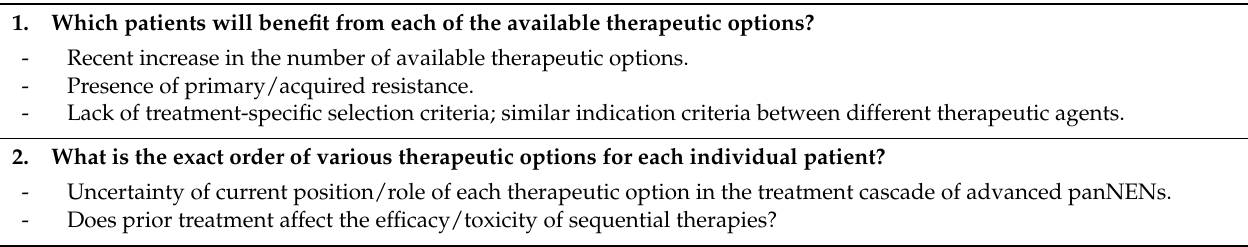
Table 1. Reasons for the emerging need for prognostic markers predictive for response/survival and/or development of resistance with specific nonsurgical treatments in patients with advanced